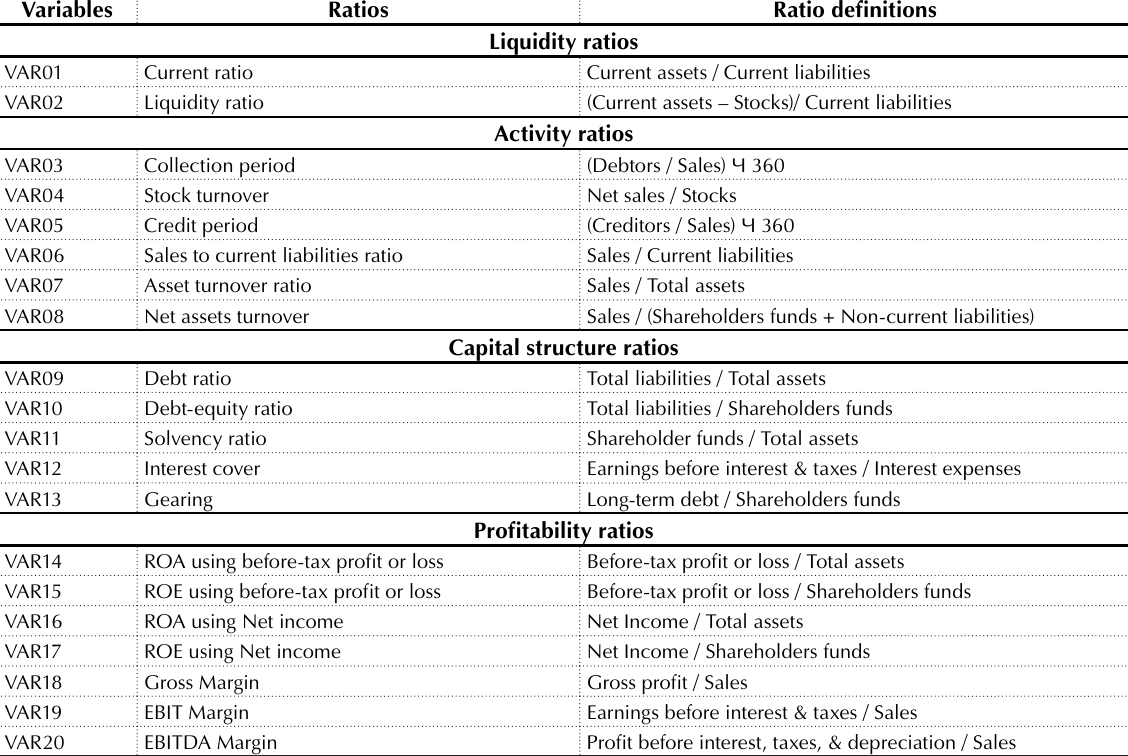
Table 3. Classification of financial ratios (quantitative